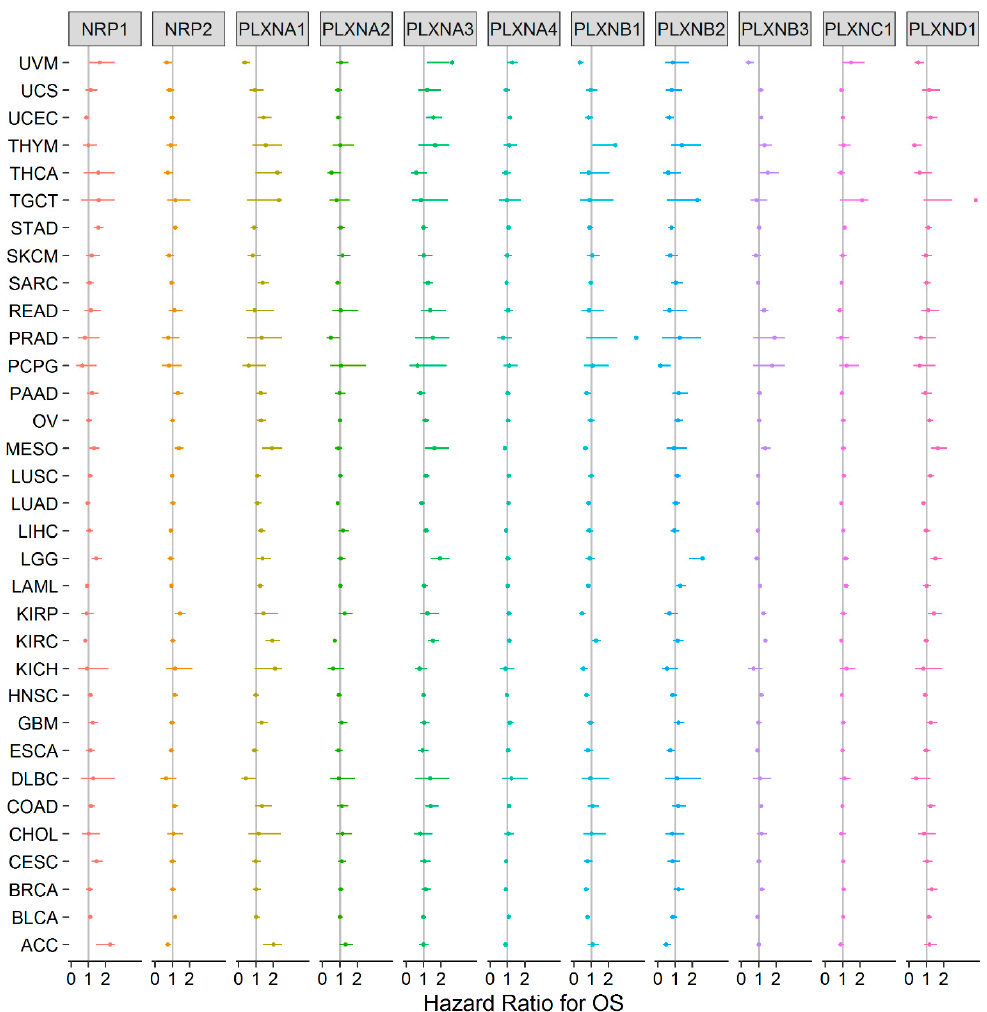
Figure 3. Association of NRP and PLXN family gene expression with patient overall survival for different cancer types. The forest plot with the hazard ratios (HR) and 95% confidence intervals for overall survival for different cancer types to show survival advantage (HR < 1) and disadvantage (HR > 1) with increased gene expression of NRPs and PLXNs. Univariate Cox proportional hazard regression models were used for the association tests. p < 0.05 was considered as significance.